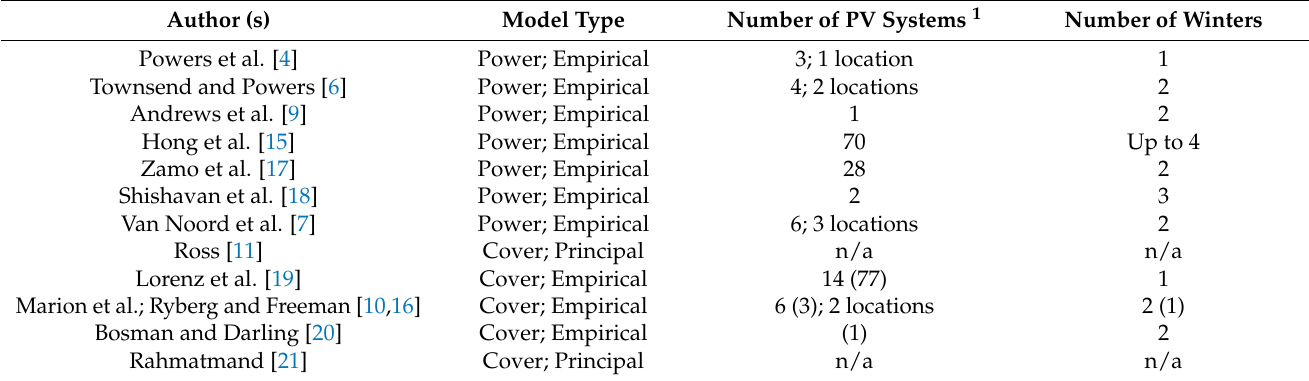
Table 1. Overview of models for long-term prediction of snow losses, either directly (designated “Power” under Model Type) or through snow cover predictions (denoted as